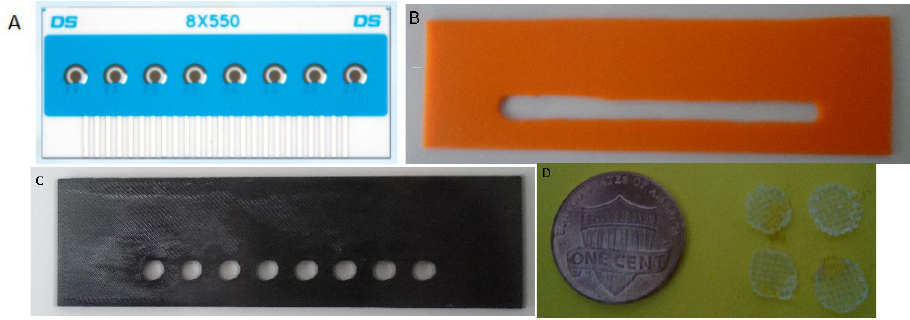
Fig. 2. (A) DropSens 550 screen-printed electrochemical array, (B) silicone sealing, (C) membrane holder, and (D) membranes. Master Dual Pump model AL 1000 was used to pump the electrolyte. 20 cm 3 syringe was used which had diameter 20 mm (lot 15f15c8; ref 4645200v). The pumping speed of the electrolyte was varied from 0 to 3 cm 3 min −1